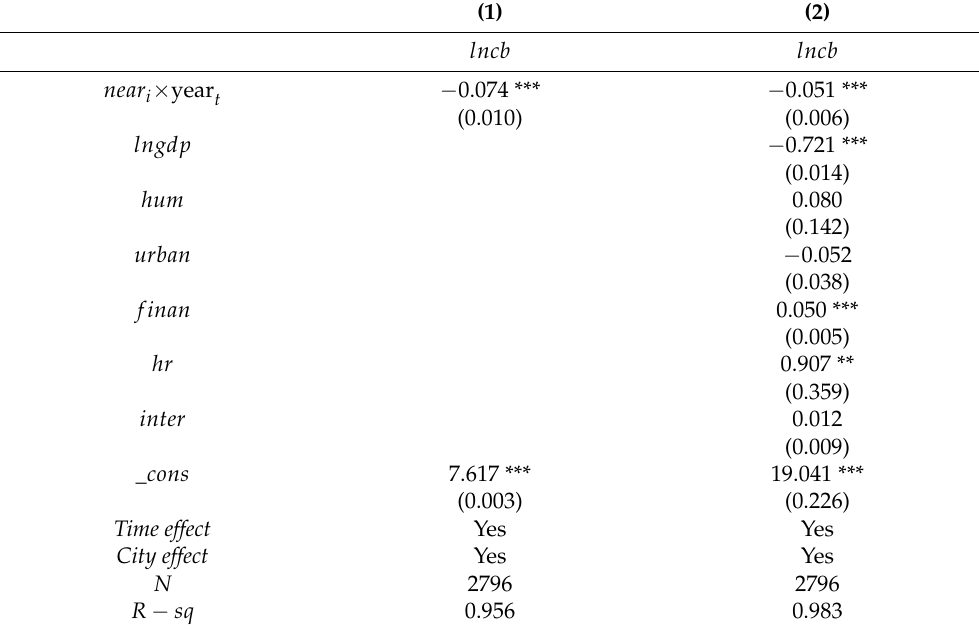
Table 10. The spatial effects of